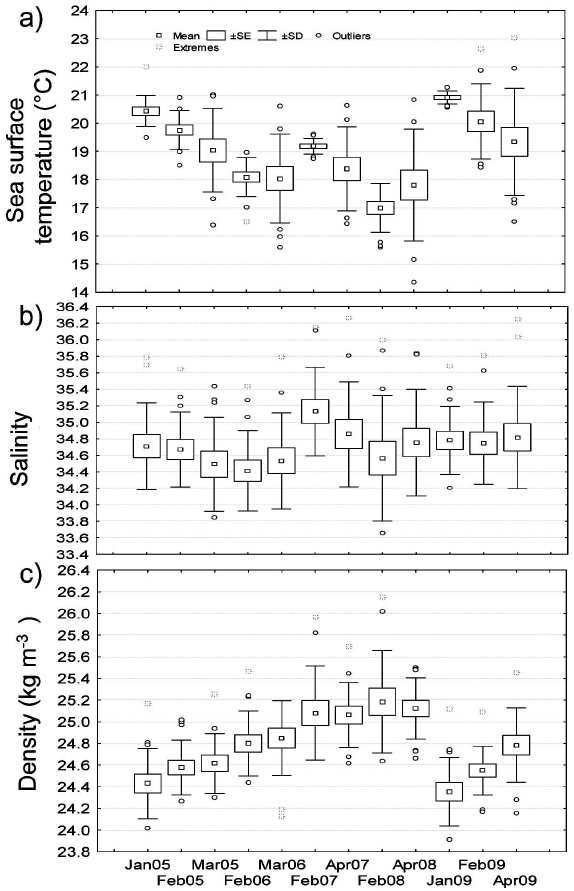
Fig . 3. – Box plots: a) sea surface temperature (°C), b) salinity, and c) density (kg m –3 ) during winter and early spring 2005-2009 in Bahía Magdalena, Baja California Sur.